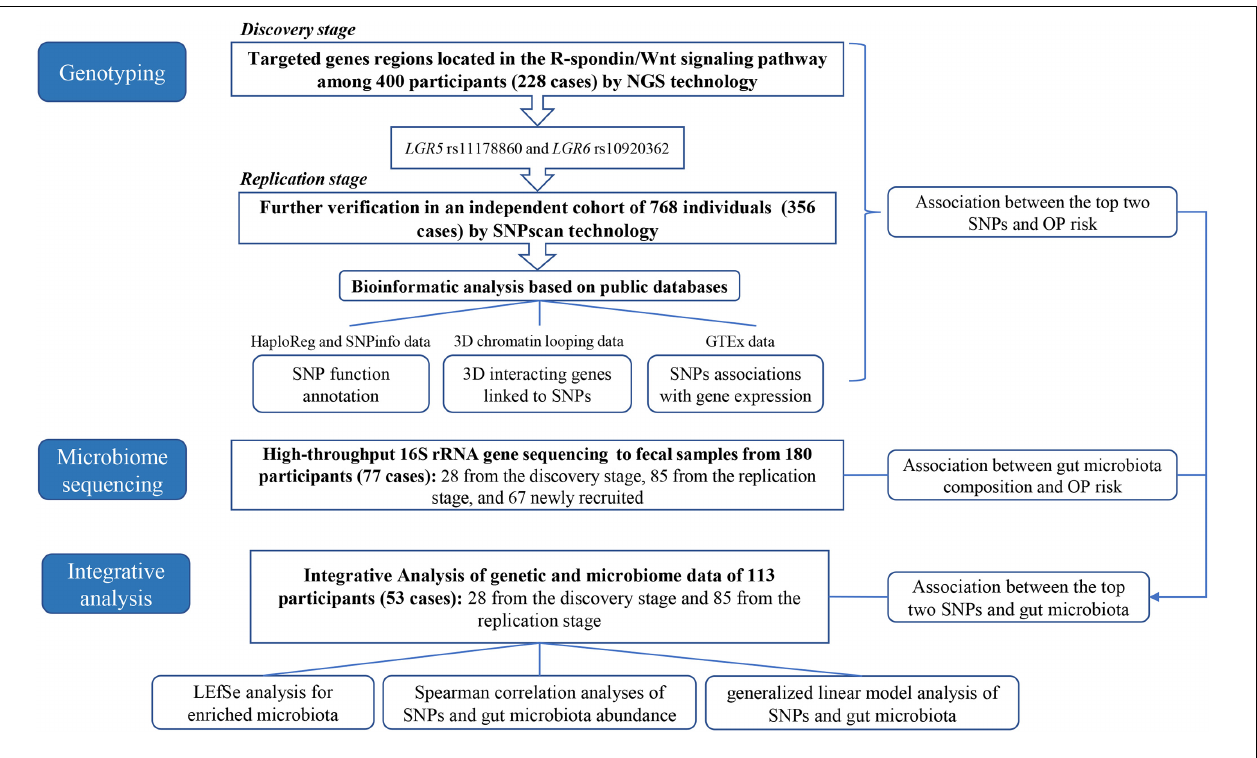
FIGURE 1 | Framework of the design and data analysis of this